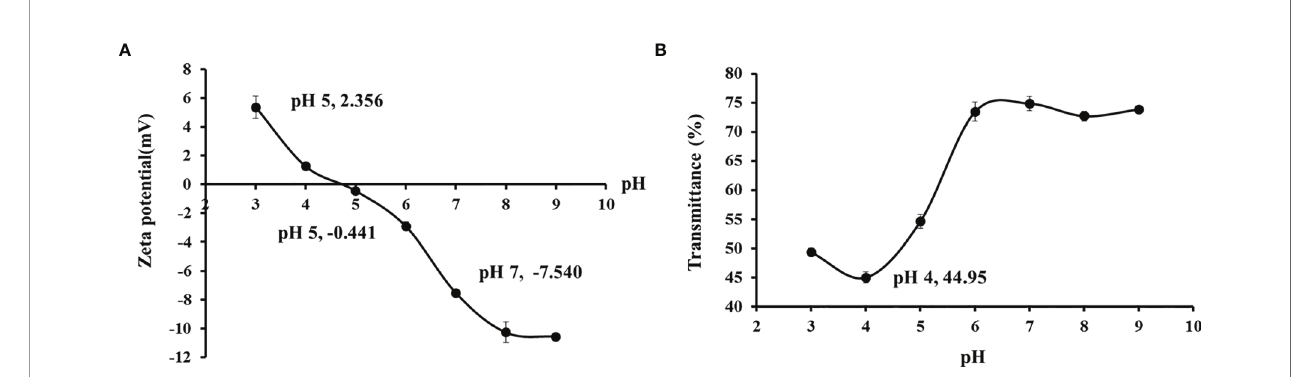
FIGURE 5 | Zeta potential (A) and transparency (B) of cartilage gelatin from Siberian sturgeon. All data are expressed as mean ± SD ( n = 3).